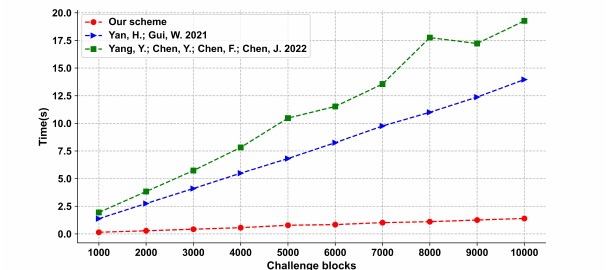
Figure 6. Computation cost of ProofVerify